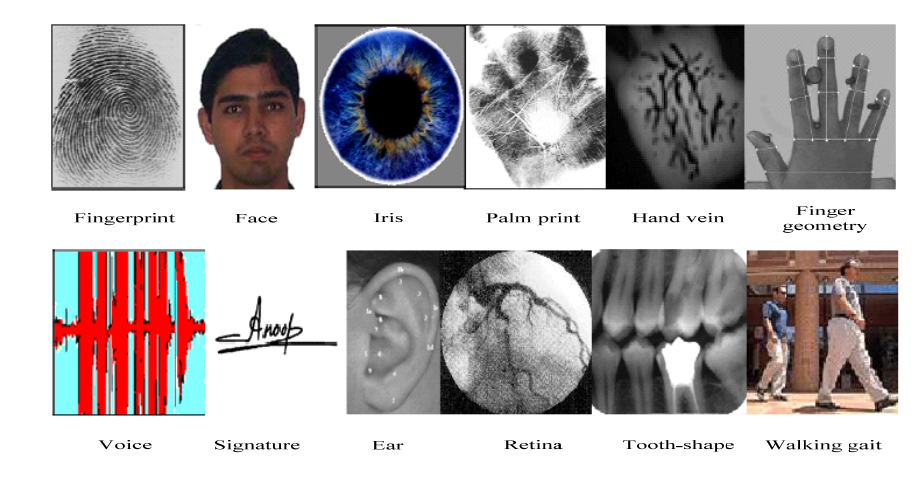
Figure 1. Various biometric features.